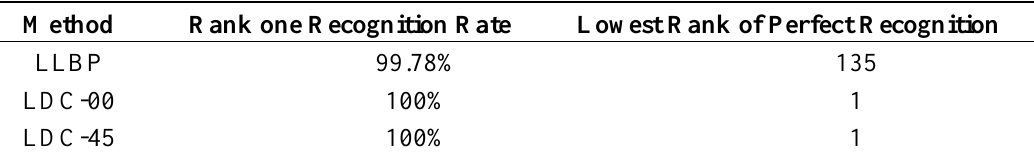
Table 2. Identification performance by different methods.